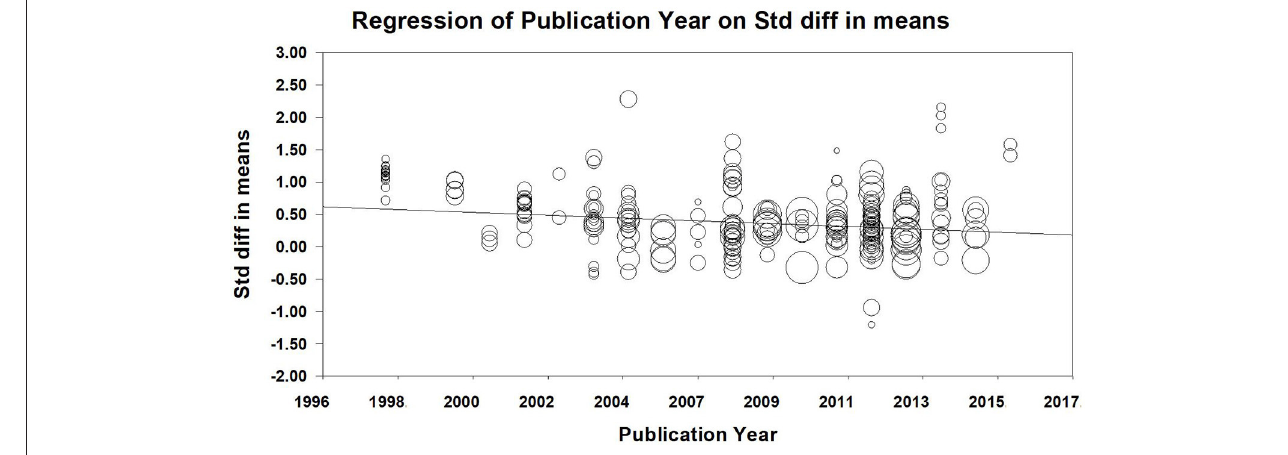
FIGURE 2 | The moderating effect of publication year.